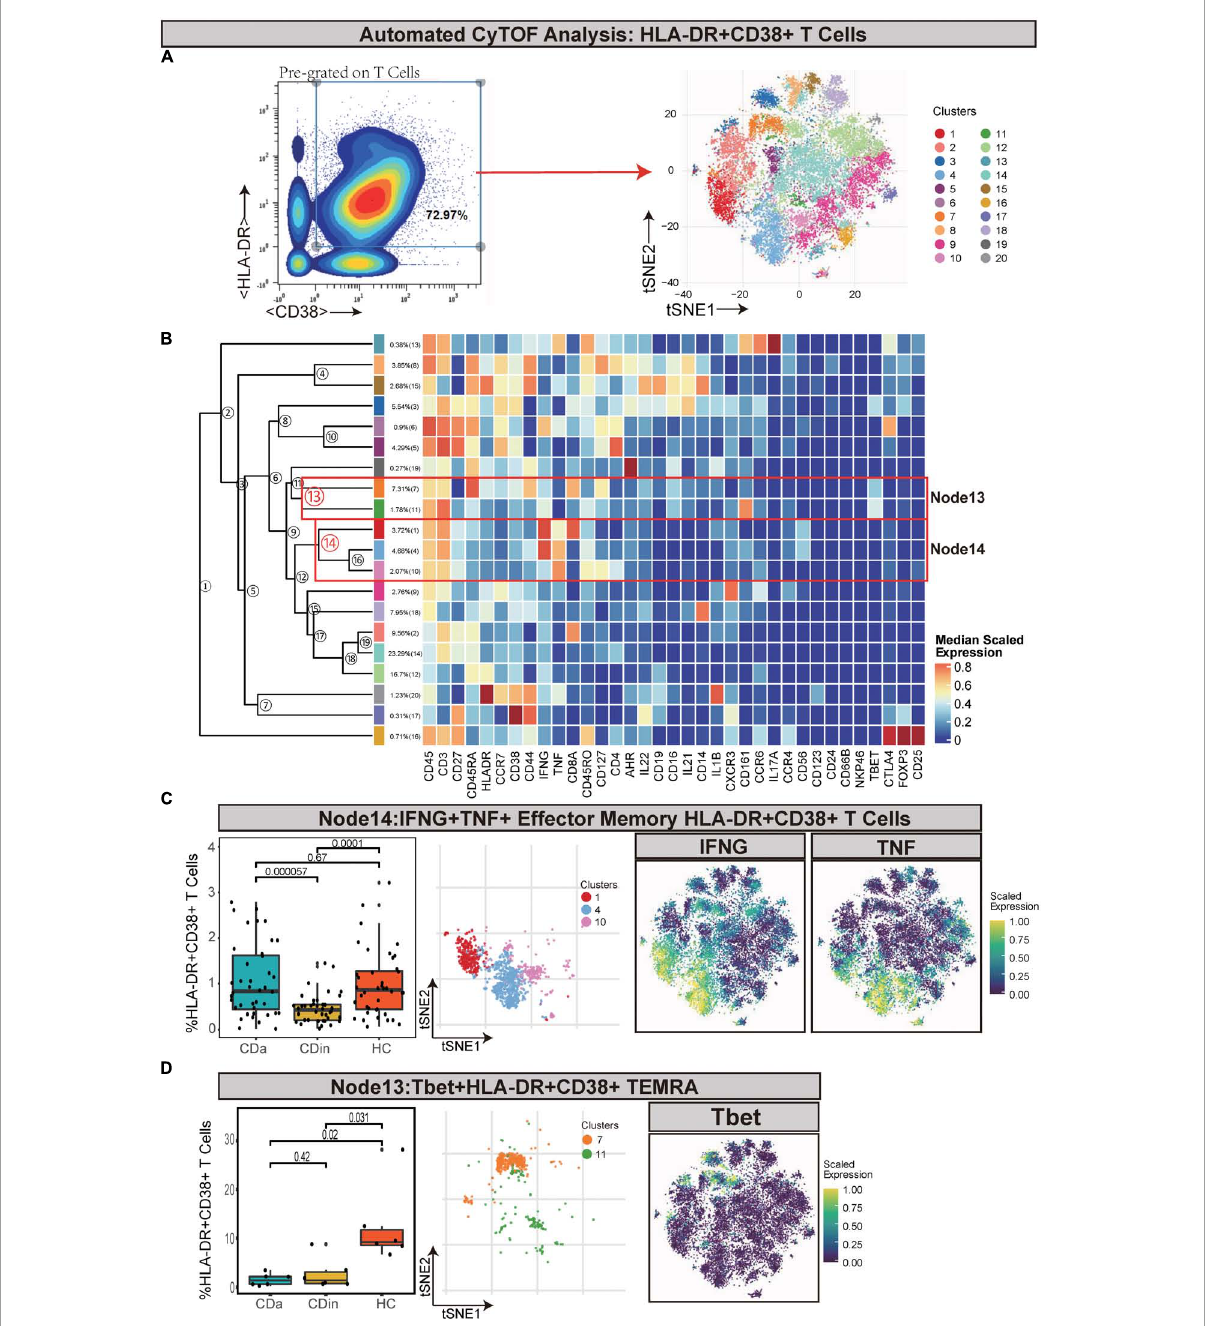
FIGURE2 CyTOF analysis showed differences in HLA-DR + CD38 + T cells among CDa, CDin, and HC. (A) Gating strategy (left) and t-SNE projection (right) of HLA-DR + CD38 + T cells derived from CyTOF data. (B) Cluster dendrogram and heatmap of HLA-DR + CD38 + T cells. (C) The percentage of Node14 in HLA-DR + CD38 + T cells among three groups (left) and the t-SNE plot of Node14 with gene expression feature plot for IFNG/TNF (right). (D) The percentage of Node13 in HLA-DR + CD38 + T cells among three groups (left) and the t-SNE plot of Node13 with gene expression feature plot for Tbet